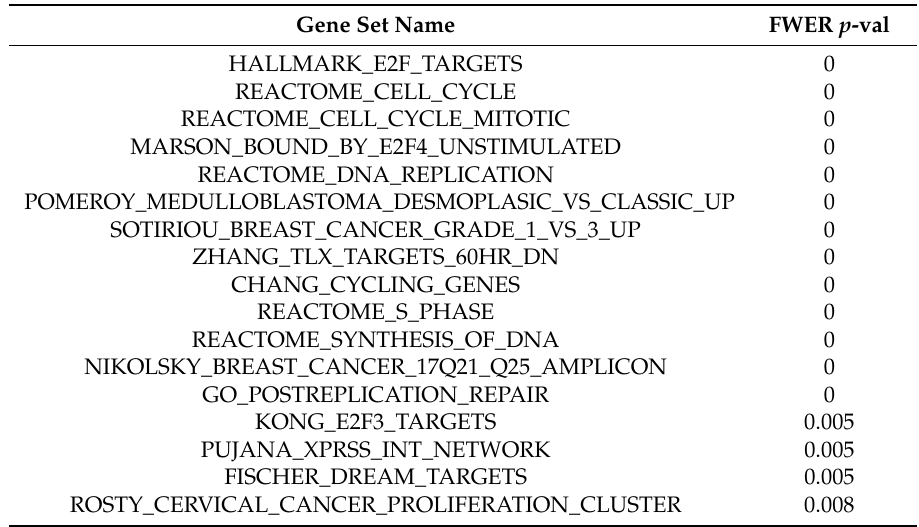
Table 3. Top Gene Set Enrichment Analysis (GSEA) categories for genes upregulated in mouse but not human SHH-MB (FWER—family-wise error